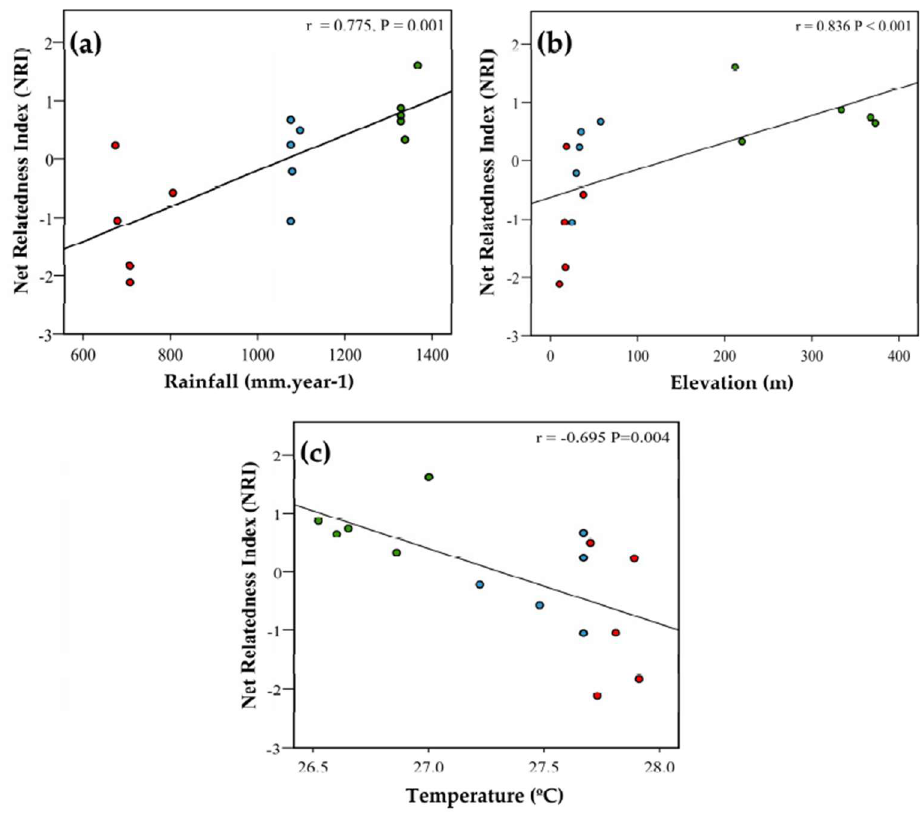
Figure 3. Pearson correlations between Net Related Index of study plots and ( a ) rainfall (mm year − 1 ), r = 0.862, p < 0.001; ( b ) elevation r = 0.626, p < 0.012; and ( c ) temperature (°C) r = −0.648, p = 0.009.